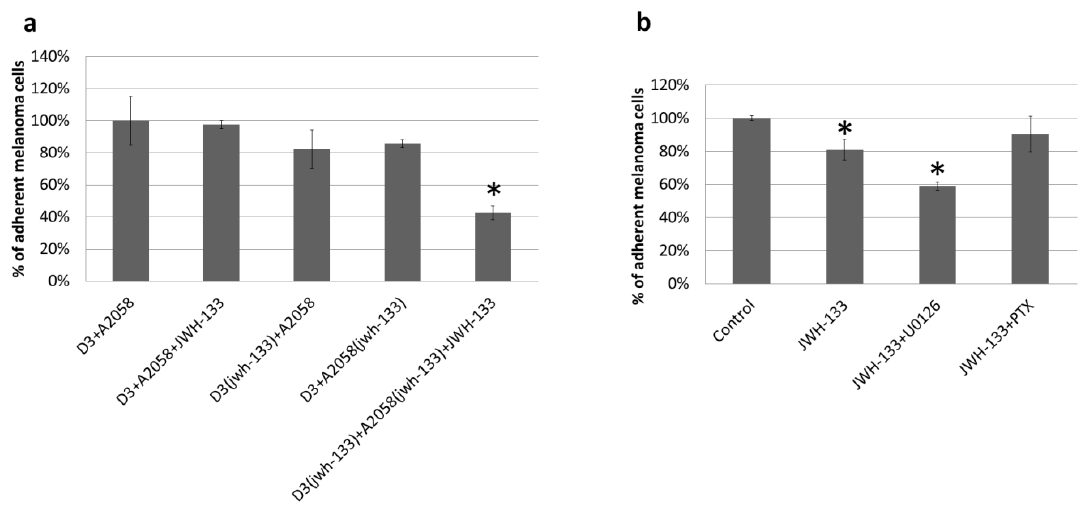
Figure 2. Effect of CB2 activation on the attachment of melanoma cells on the brain endothelium. Results are represented as % control ( i.e. , D3 + A2058) and given as mean ± SD. N = 3. * p < 0.05 as assessed by ANOVA and Bonferroni’s post-hoc test. ( a ) D3(jwh-133) and A2058(jwh-133) represent cells pre-treated with 10 µM JWH-133 for 4 h. D3 + A2058 + JWH-133 denotes cells treated with 10 µM JWH-133 during the 90 min adhesion assay; ( b ) JWH-133 (10 µM), U0126 (10 µM) and PTX (100